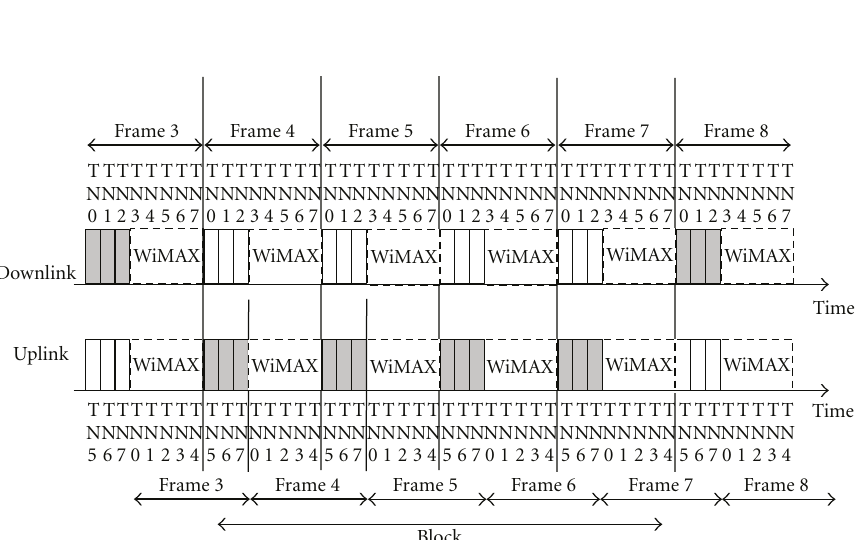
Figure 13: The allocation of uplink and downlink time slots.